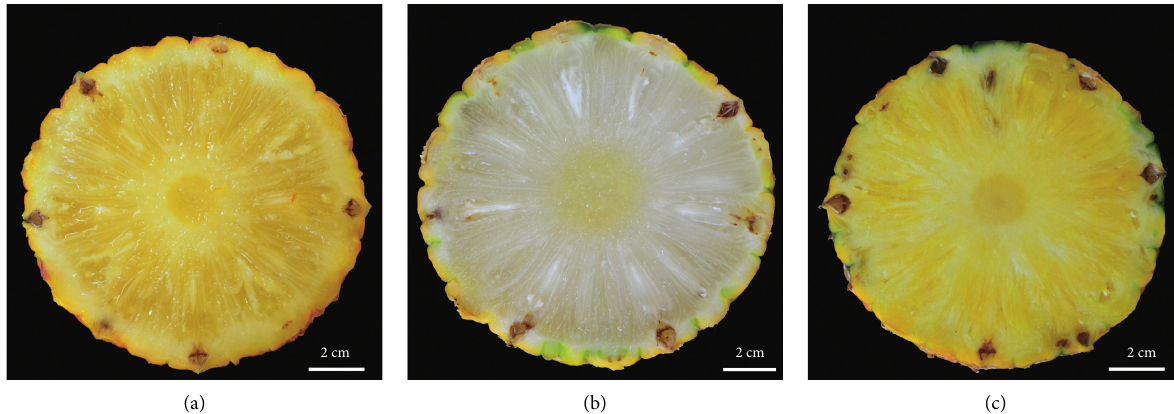
Figure 4: Comparison of the pineapple cuts of (a) Smooth Cayenne, (b) Santa Rosa ecotype, and (c) Golden. Table 3: Fruit chemical characteristics of three pineapple cultivars grown at different sowing densities.